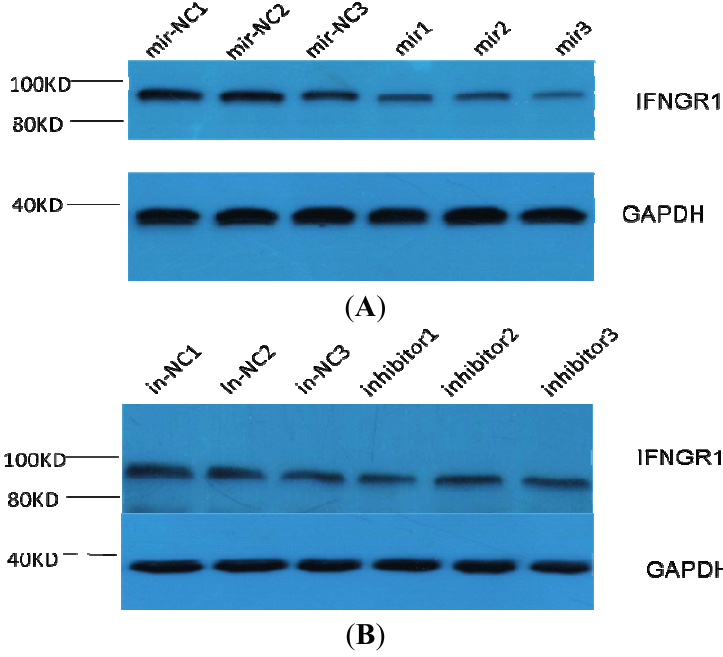
Figure 4. Expression of endogenous IFN- γ R1 in THP-1 cells by miR-548ah mimics ( A ) and inhibitors ( B ). Glyceraldehyde-3-phosphate dehydrogenase (GAPDH) was used as an internal control. Legend: mir-NC 1 to 3 and In-NC 1 to 3 are normal control of miR-548ah-5p; mir1 to 3 are miR-548ah-5p mimic; inhibitor 1 to 3 are miR-548ah-5p inhibitors.